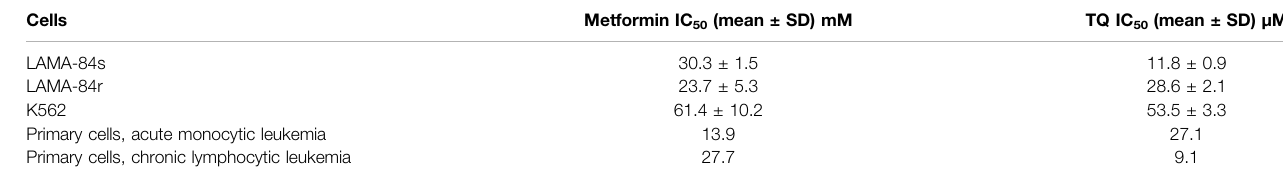
TABLE 1 | IC 50 values of metformin and thymoquinone (TQ) after 48 h treatment in leukemia cells, as determined by the WST-8 assay. Cells